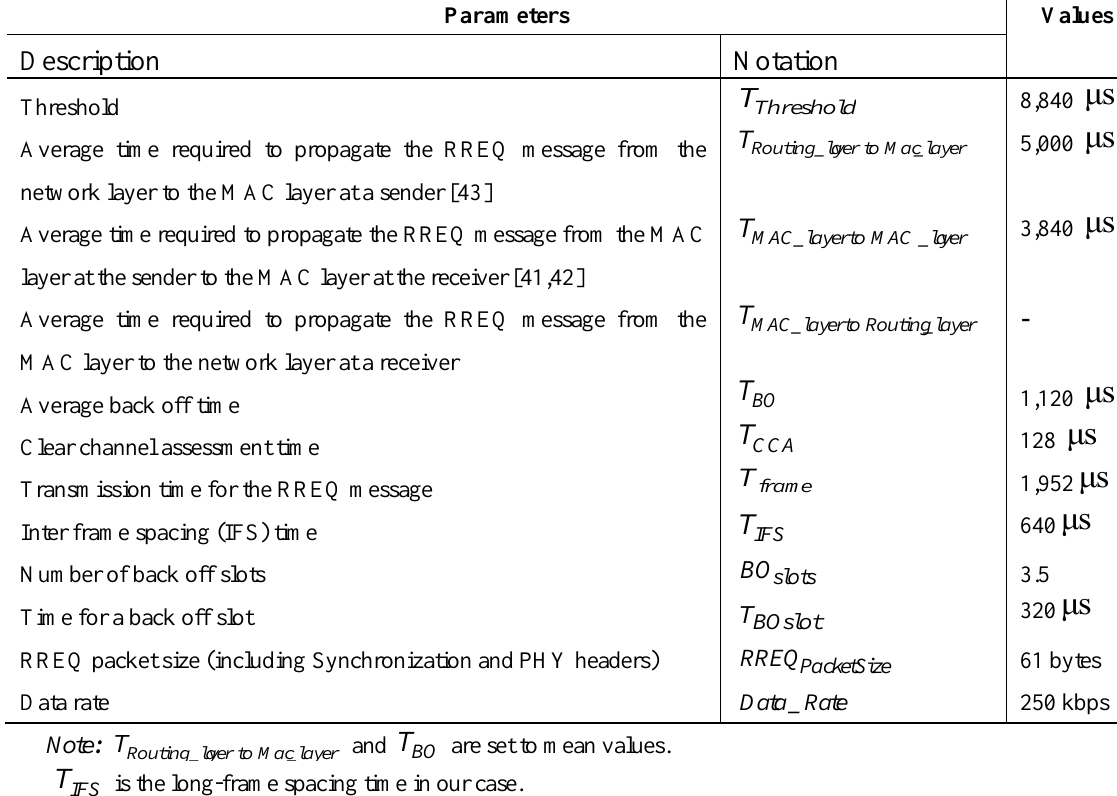
Table 5. Parameters used for the threshold